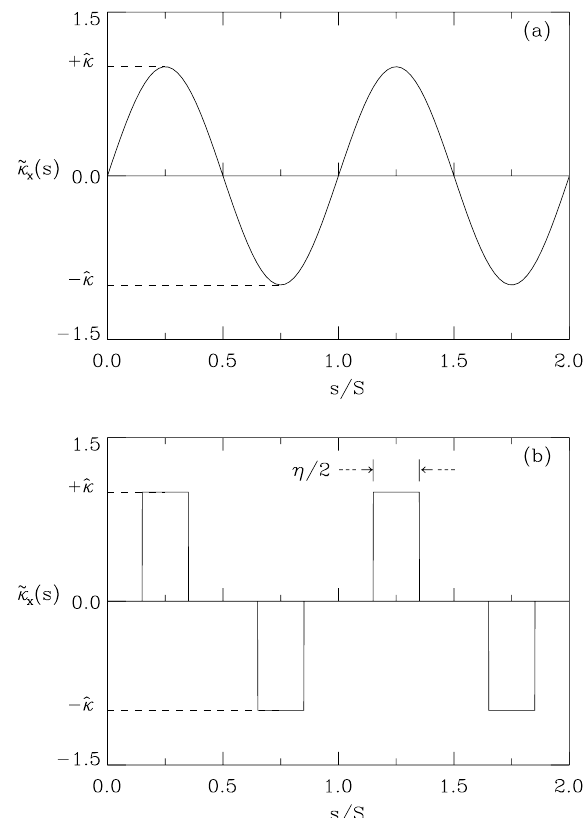
FIG. 1. Examples of periodic-focusing lattice functions with odd half-period symmetry [Eq. (52)] corresponding to (a) a sinusoidal lattice function, ˜ k x (cid:2) s (cid:3) (cid:1) ˆ k sin (cid:2) 2 p s (cid:5) S (cid:3) , with ˆ k (cid:1) const, and (b) a periodic step-function lattice with amplitude ˆ k (cid:1) const and filling factor h .